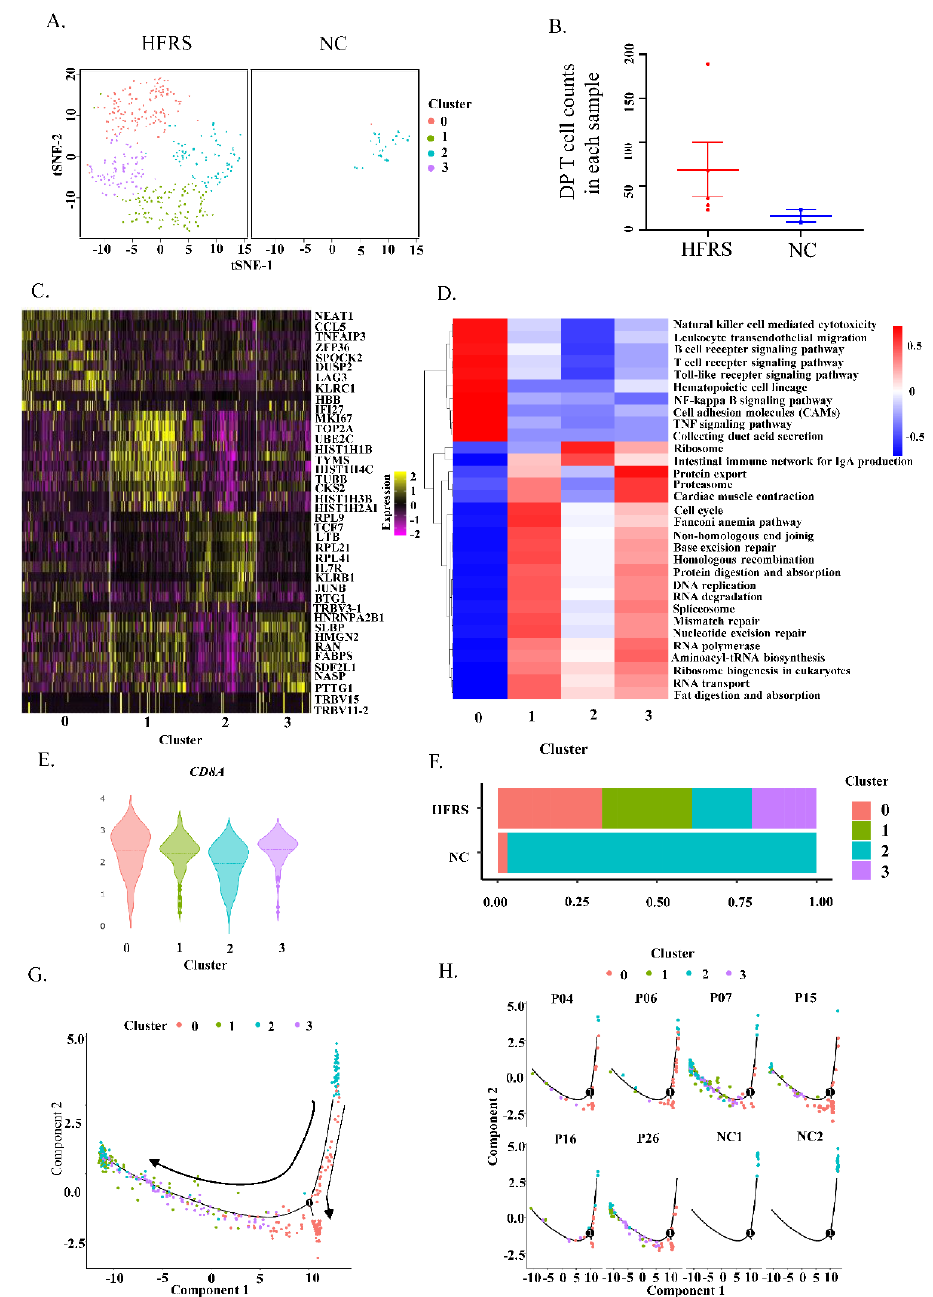
Figure 2. Identified DP T cells in HFRS patients by scRNA-seq. ( A ). t-SNE plot showing DP T cells from both HFRS and NC. ( B ) Dot plot showing the comparison of DP T cell counts in each sample of HFRS and NC. ( C ) The heatmap presenting gene expression profile of each cluster in DP T cells. ( D ) The KEGG heatmap displaying the pathway activation in each cluster of DP T cells. ( E ) The violin graph showing the comparison of CD8 α gene expression in each cluster. ( F ) The bar graph presenting the cluster distribution in both HFRS and NC. ( G ) The pseudotime trajectory analysis of DP T cells. ( H ) The pseudotime trajectory analysis of DP T cells in each sample.